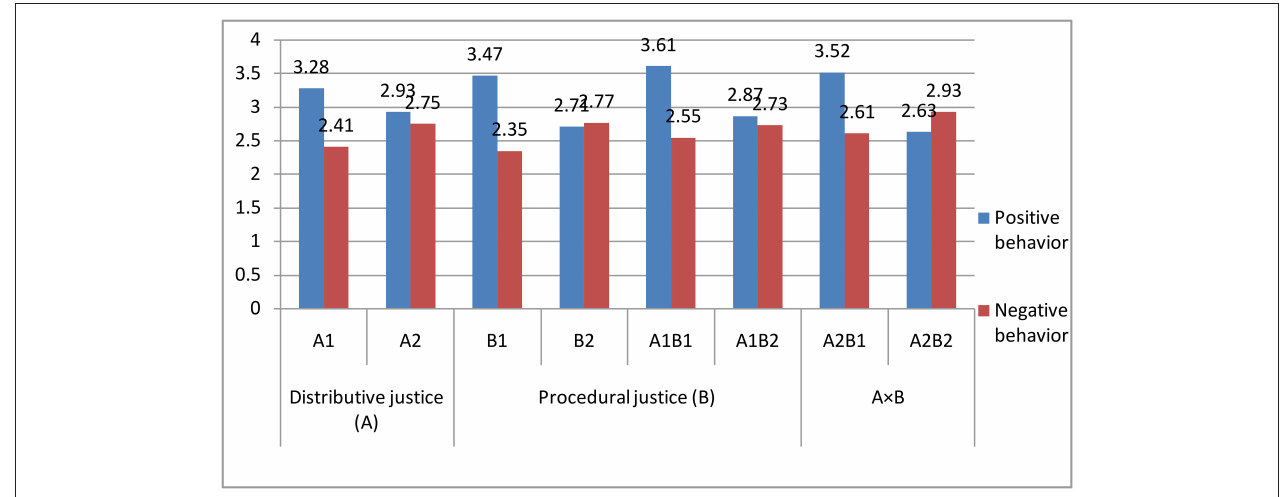
FIGURE 4 | Effects of Distributive Justice and Procedural Justice to Positive/Negative Organizational